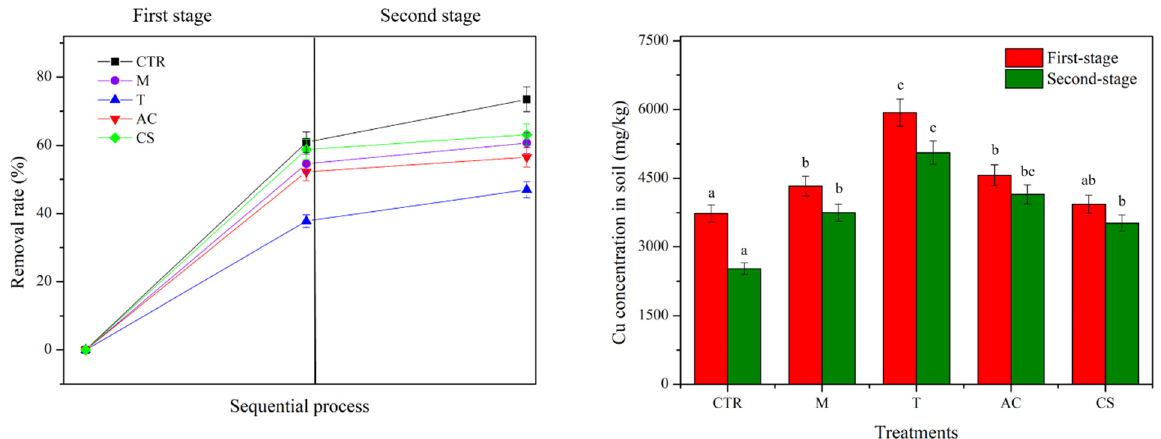
Figure 7. Removal rate of Cu in the soil when assessed by sequential column leaching test and plant uptake test. Means with the same letters are not significantly different from each other under different amendment treatments according to Tukey’s test ( p < 0.05, n = 3) (CTR: control; M: magnetite; T: talc; AC: activated carbon; CS: cornstarch).